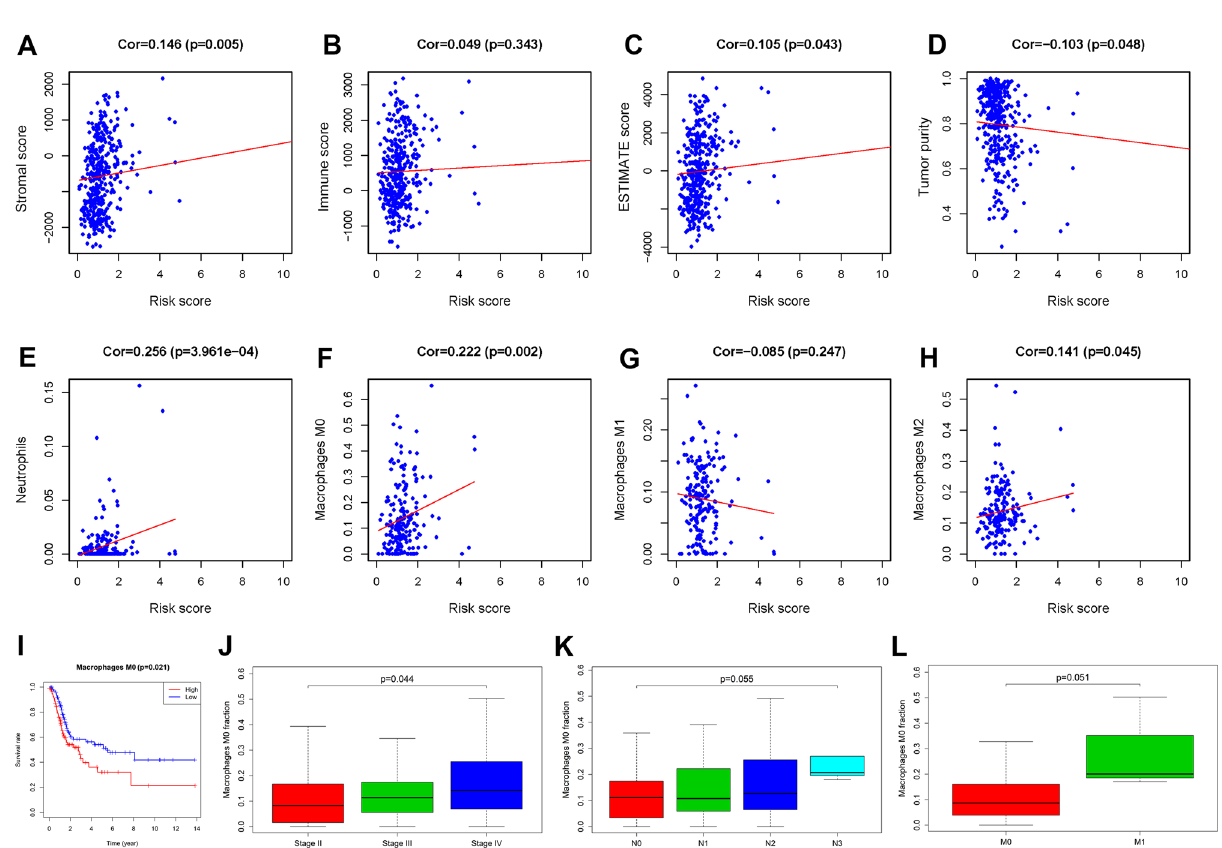
Figure 7. The correlation between risk score and TME. ( A ) Risk score and stromal score. ( B ) Risk score and immune score. ( C ) Risk score and ESTIMATE score. ( D ) Risk score and tumor purity. ( E ) Risk score and neutrophils. ( F ) Risk score and macrophage M0. ( G ) Risk score and macrophage M1. ( H ) Risk score and macrophage M2. ( I – L ) Macrophage M0 and clinical